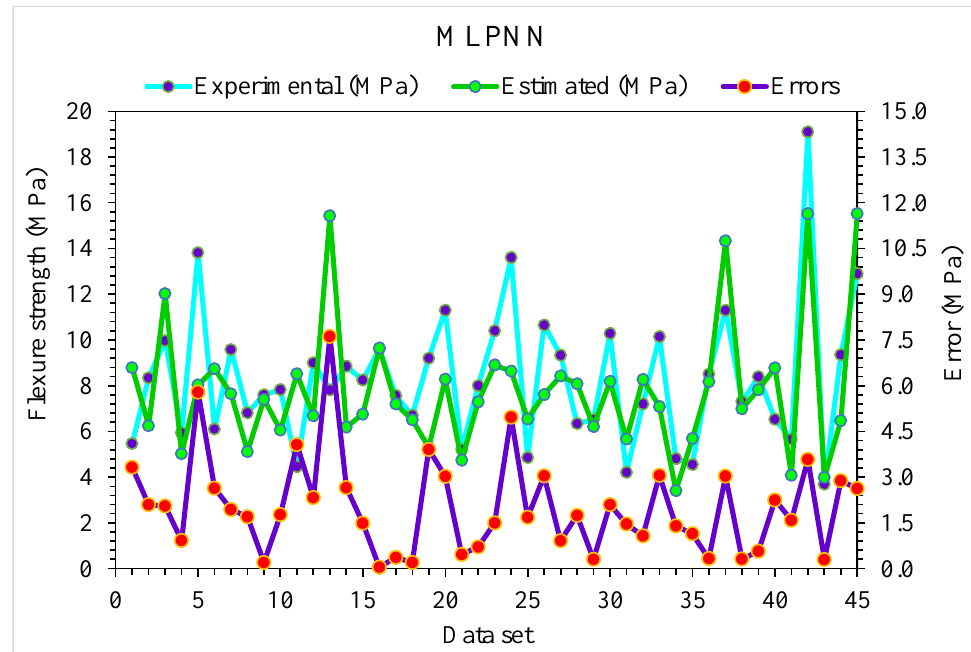
Figure 7. Experimental and MLPNN predicted values with errors for flexural strength.